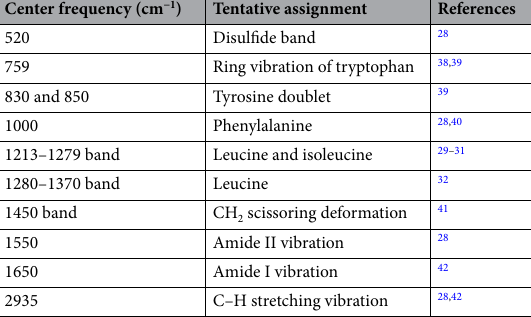
Table 2. Tentative assignment of the main vibrational bands based on the